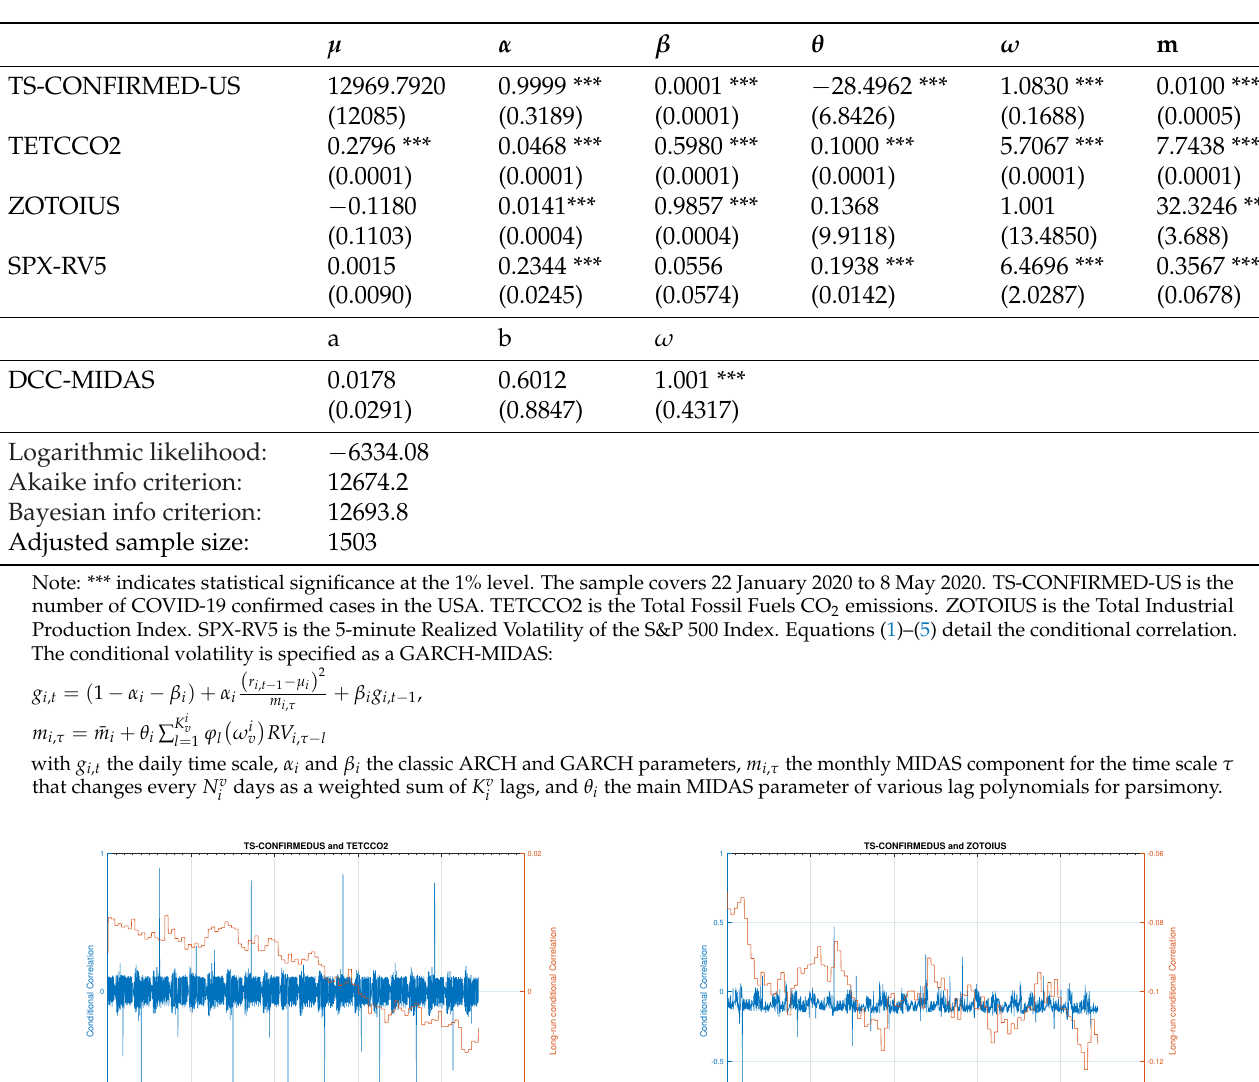
Table 4. Dynamic Conditional Correlation with Mixed Data Sampling (DCC-MIDAS) estimates when introducing COVID-19 confirmed cases to the baseline that is composed of Total Fossil Fuels CO 2 emissions, Total Industrial Production Index, and S&P 500 Index.